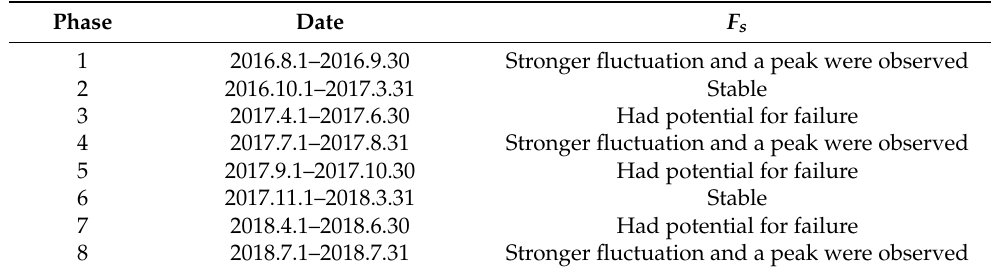
Table 4. The date and F s description of